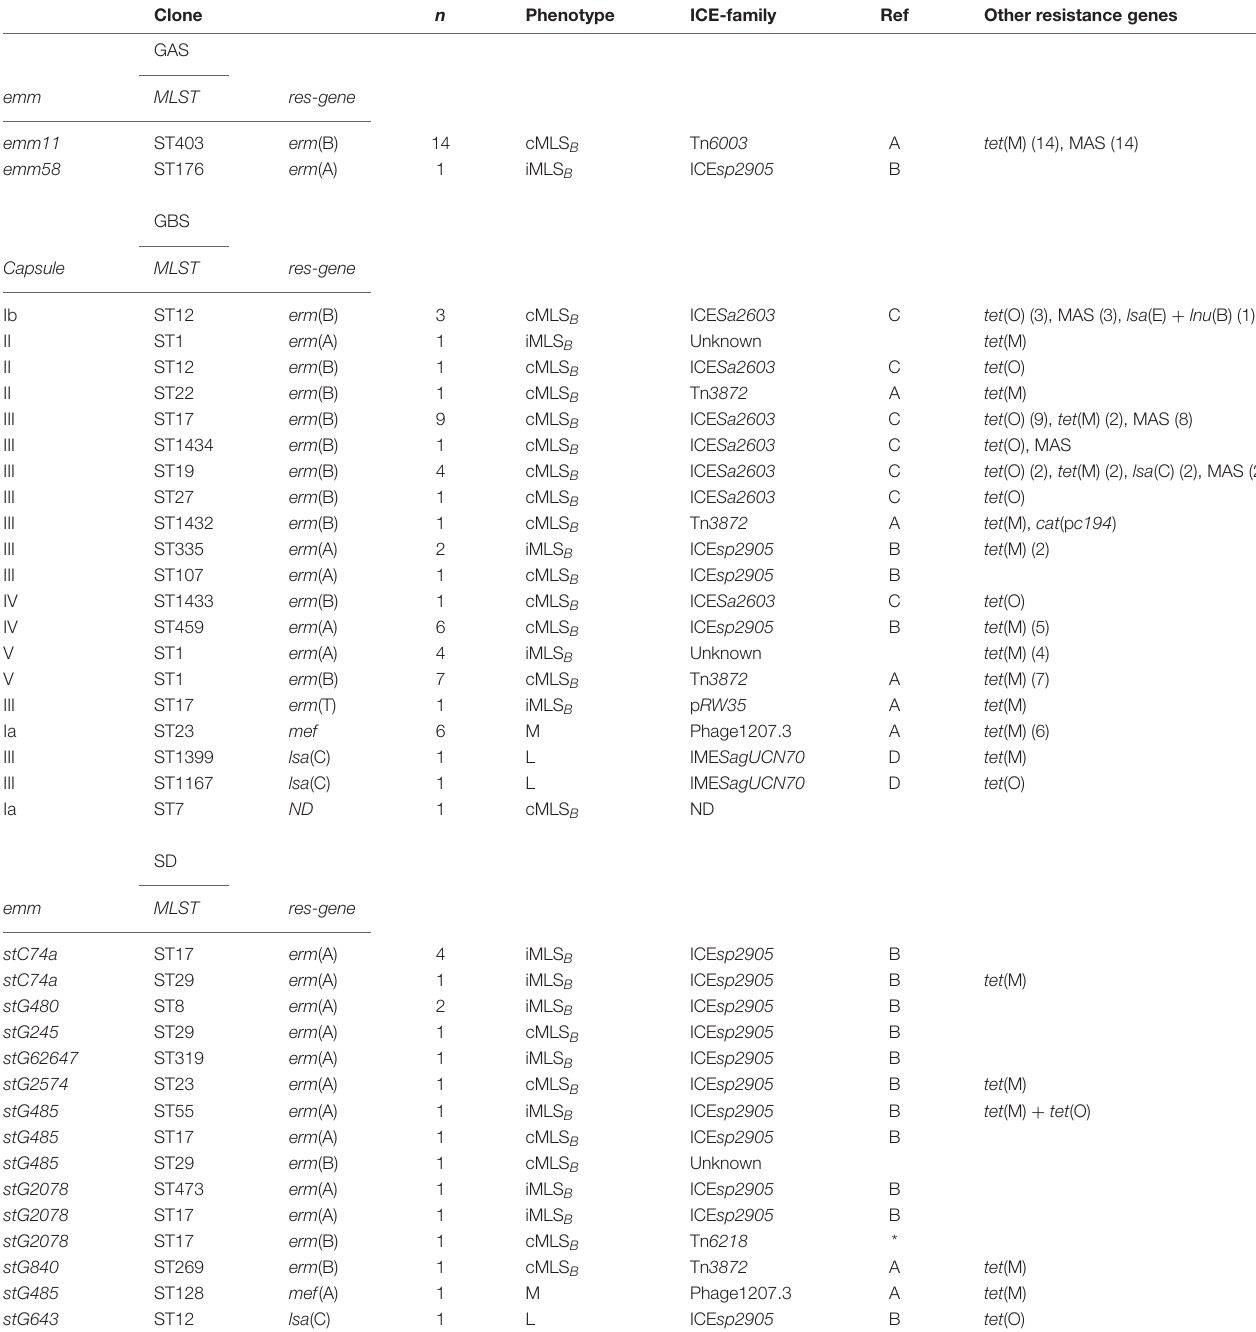
TABLE 3 | Genetic characterization of the resistant BHS